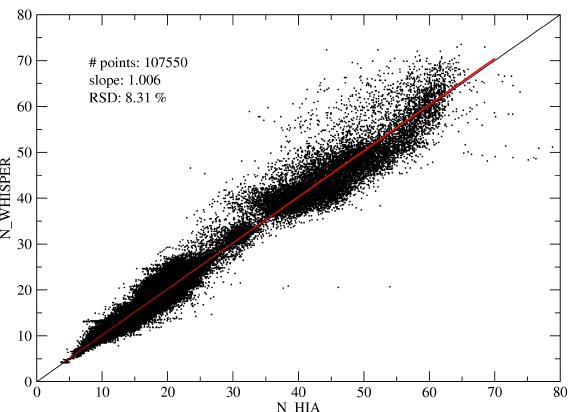
Fig. 7. Comparison between calibrated HIA and WHISPER data on Cluster 1. All solar wind intervals sampled by the HIA LS side between 15 December 2006 and 15 February 2007 were selected for comparison using selection criteria similar to those presented in Sect. 4. The regression line crossing the origin is shown in